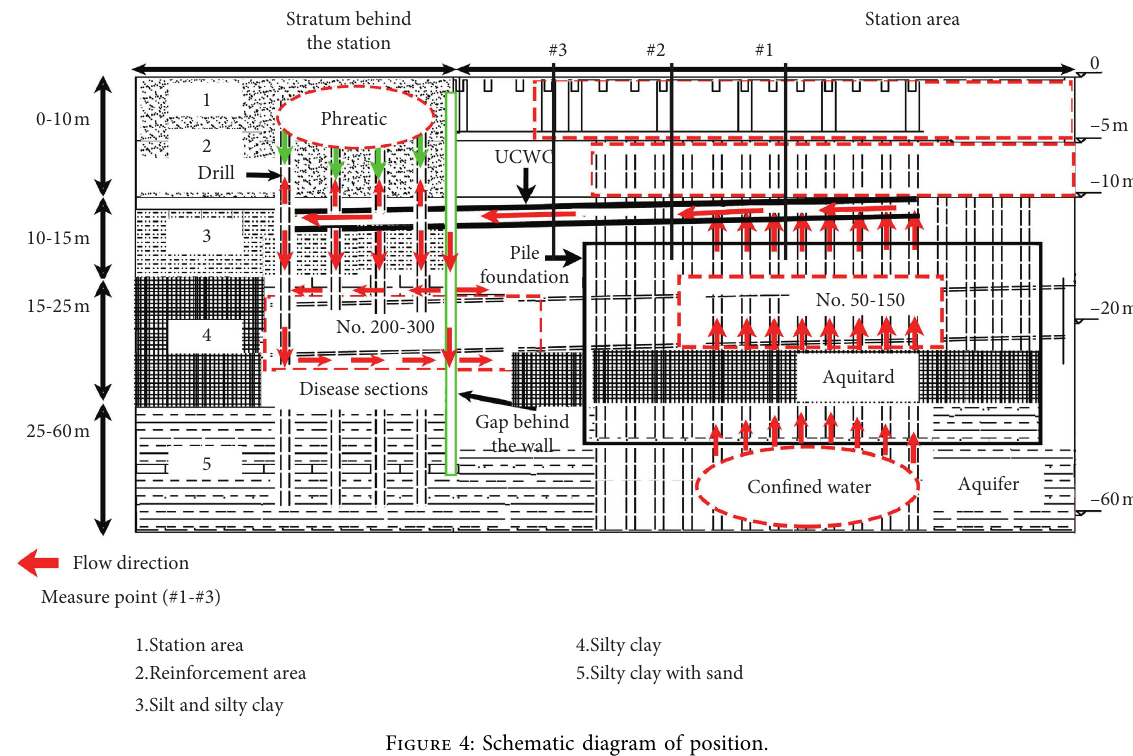
Figure 4: Schematic diagram of